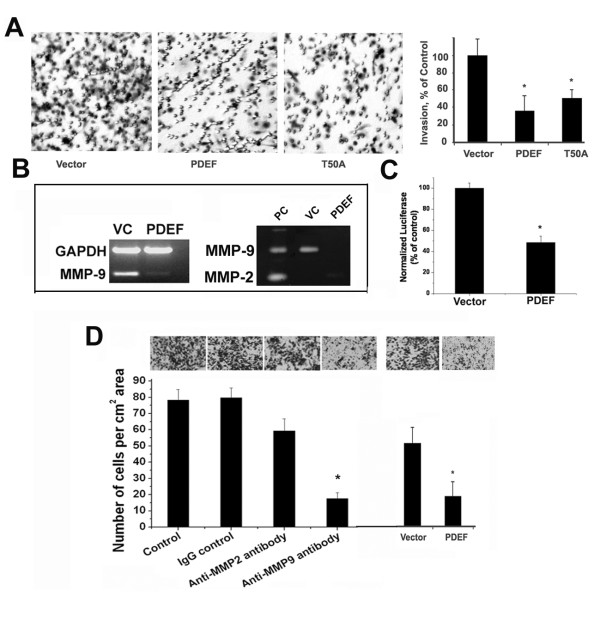
Effect of PDEF on invasion through Matrigel Matrix and MMP9 mRNA expression, MMP9 promoter activity and MMP9 enzymatic activity of prostate cancer cells. A, Invasion of PC3 cells expressing PDEF or PDEF T50A through Transwell membranes as described in Methods. B, RT-PCR showing MMP9 mRNA (left panel) and MMP9 enzymatic activity using gelatin Zymography (Right panel) was performed to determine the level of active MMP9. C, MMP9 promoter activity as determined by Luciferase reporter assay. D, Invasion of PC3 cells through a basement membrane matrix after blocking MMP9 using antibodies or overexpressing PDEF. Asterisks indicate significance levels of p < 0.05 with respect to controls.